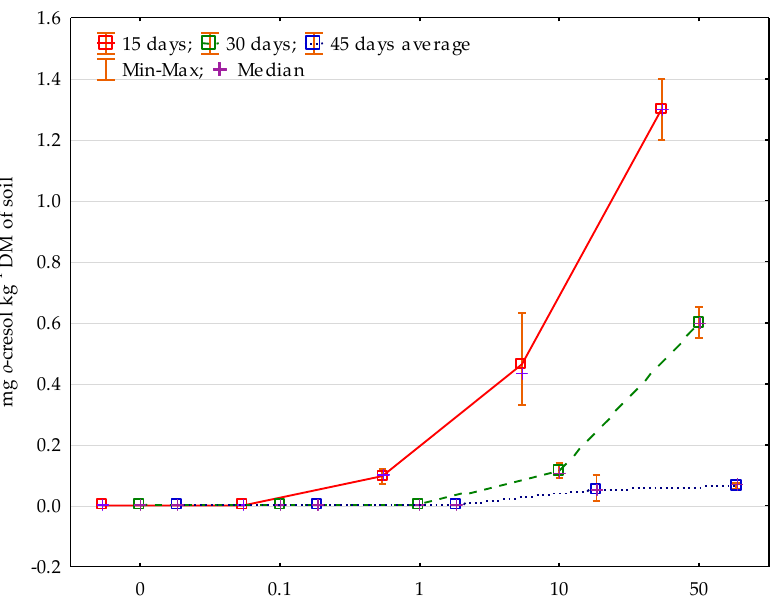
Figure 14. The content of o -cresol in the soil after 15, 30 and 45 days of research depending on o- cresol contamination; 0; 0.1; 1; 10; 50—doses of o -cresol (mg kg −1 DM of soil)